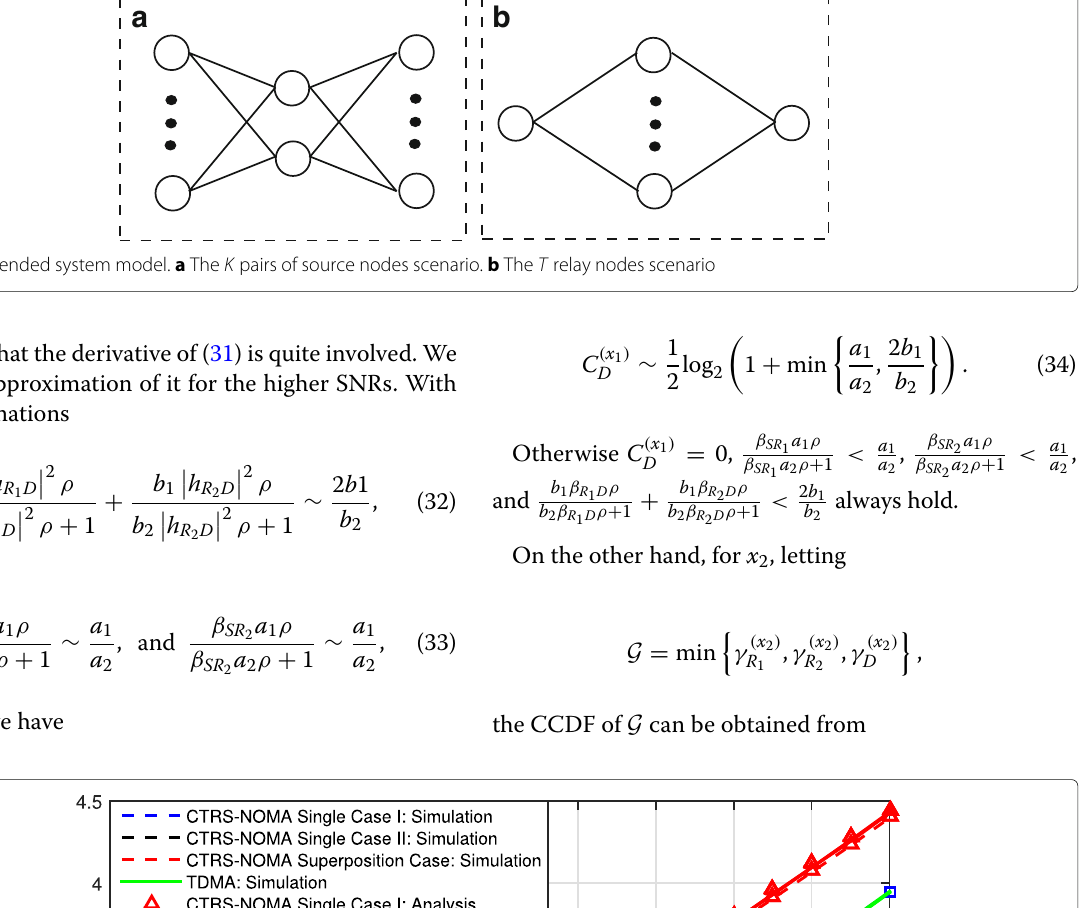
Fig. 2 The extended system model. a The K pairs of source nodes scenario. b The T relay nodes scenario